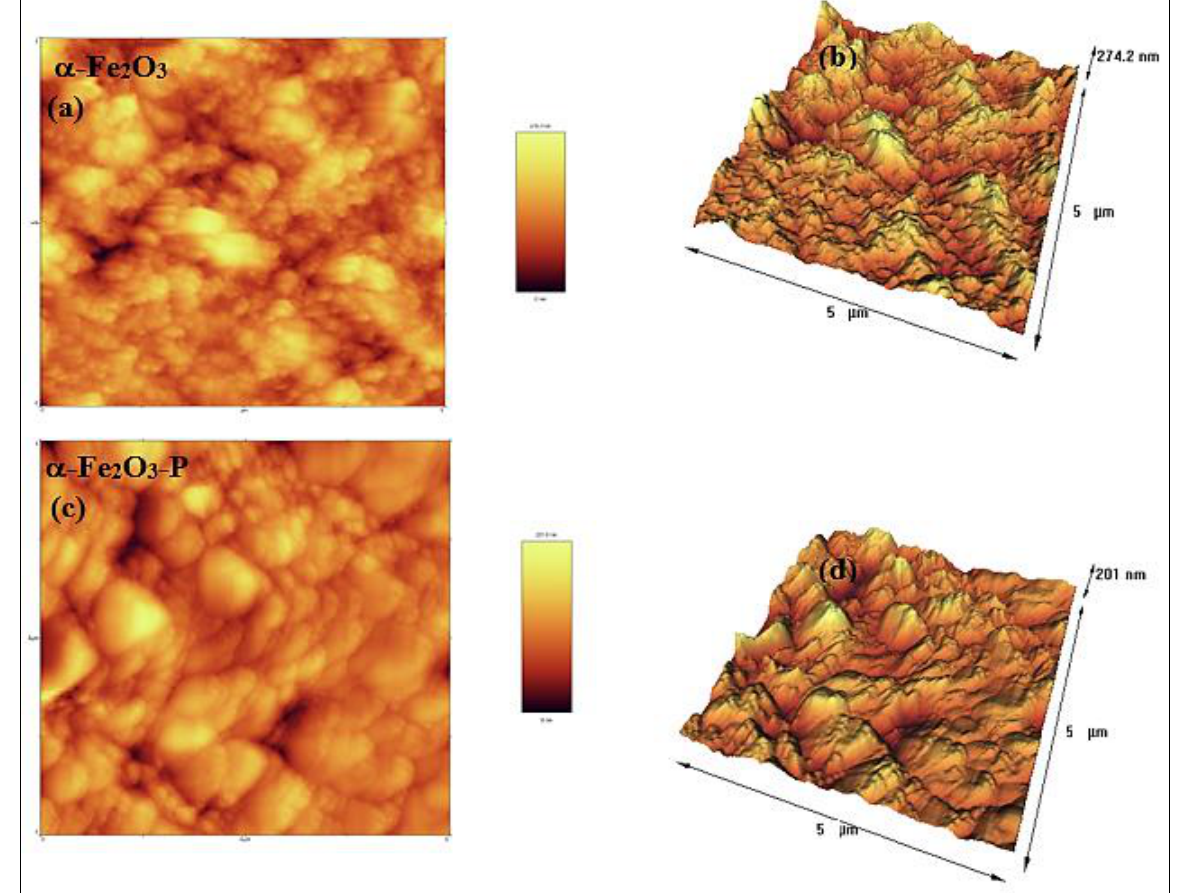
Figure 5. Surface Properties of 𝜶 -Fe 2 O 3 Films (a) Prior to Plasma Treatment (2D), (b) Prior to Plasma Treatment (3D), (c) Following Plasma Treatment (2D), (d) Following Plasma Treatment (3D) 3-4- Wettability (Contact Angle)